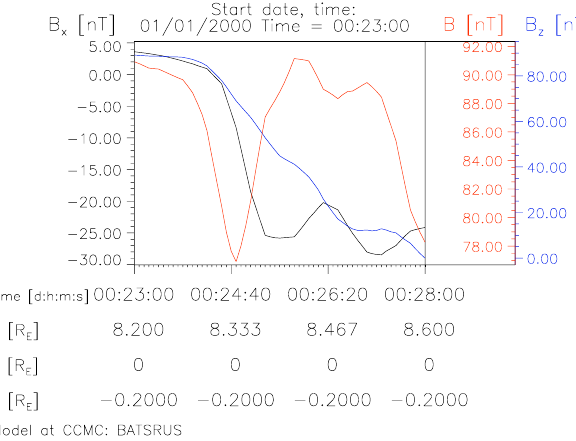
Fig. 6. Magnetic field data ( B x , B z , B ) from a virtual satellite cross- ing the southern part of the interlinked flux tubes. The satellite tra- jectory goes from the magnetosphere ( x = 8 . 2 R E ) to the magne- tosheath ( x = 8 . 6 R E ) at y = 0 and z = − 0 . 2 R E .